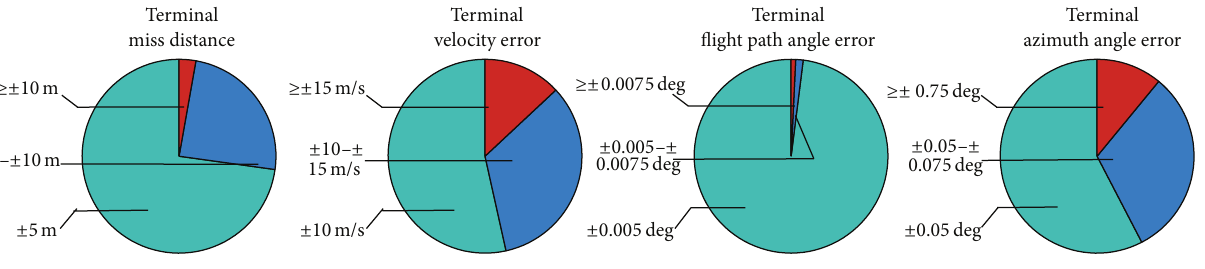
Figure 12: Statistics of terminal errors for the 500 runs.